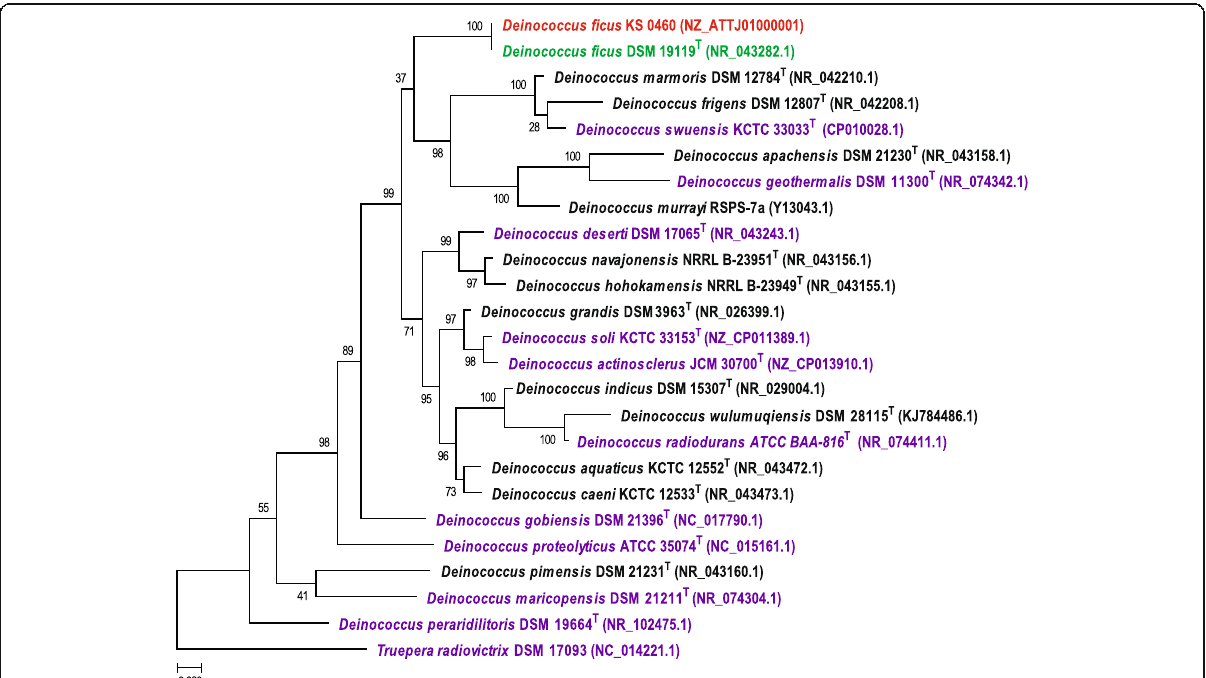
Fig. 1 16S rRNA phylogenetic tree of the Deinococcus genus. The multiple alignment of 16S rRNA sequences was constructed using MUSCLE program [58] with default parameters. The maximum-likelihood phylogenetic tree was reconstructed using the FastTree program [59], with GTR substitution matrix and gamma-distributed evolutionary rates. The same program was used to compute bootstrap values. Truepera radiovictrix was chosen as an outgroup. D. ficus KS 0460 is marked in red , D. ficus DSM 19119/CC-FR2-10 [9] - in green , completely sequenced according to NCBI genomes - in